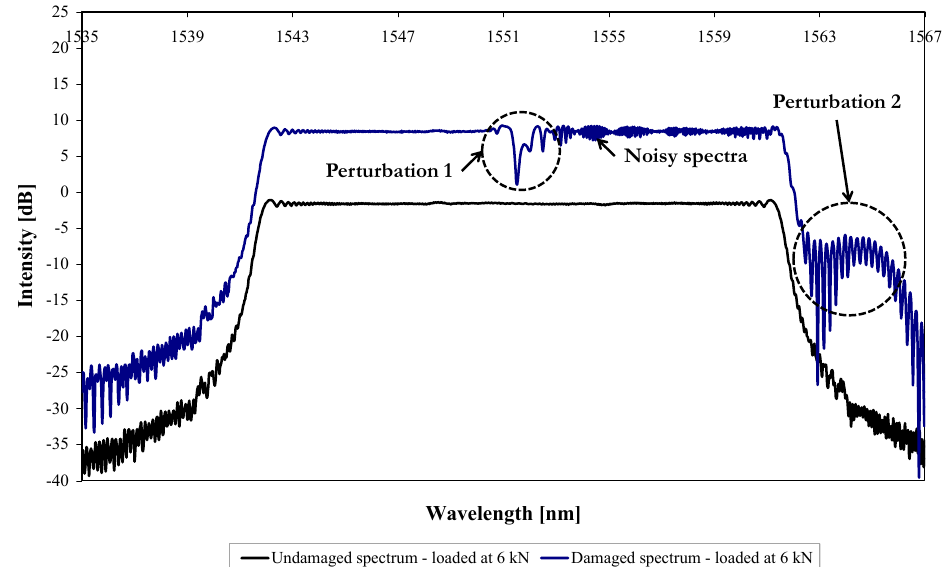
Figure 14. Predicted reflected spectra of the undamaged and the damaged models for a crack length of 12.5 mm loaded at 6 kN.